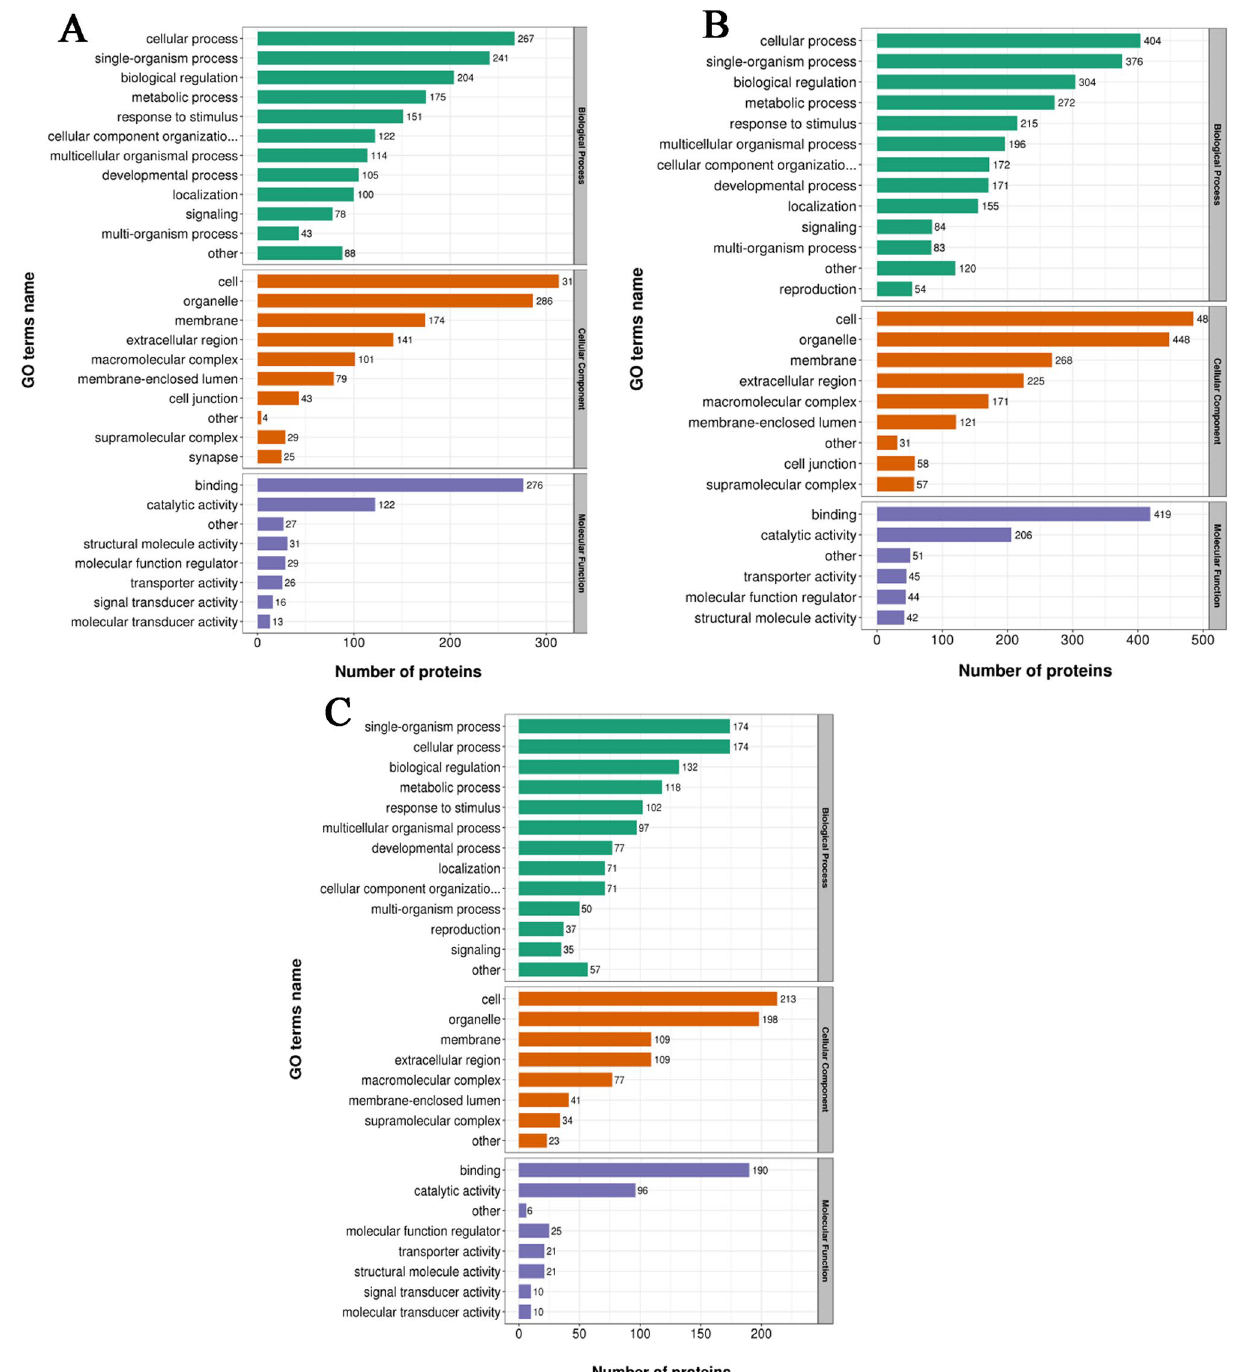
Figure 4. Gene Ontology functional analysis of differentially expressed proteins in the (A) WF/WC, (B) WS/ WF and (C) WS/WC groups. Green, red and purple represent biological process, cellular component and molecular function,